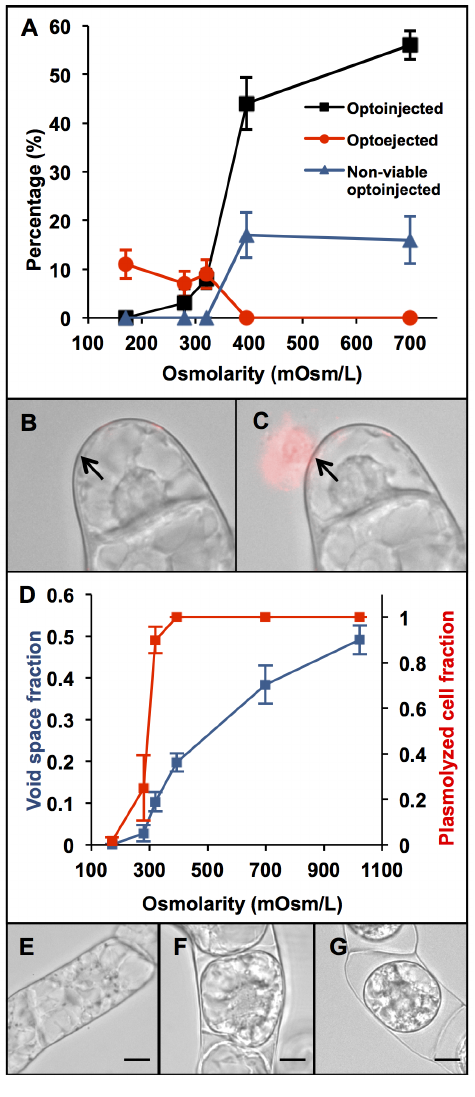
Figure 4. Optoinjection efficiency differs depending upon the osmolarity of the surrounding medium. From looking at A, as we increase the osmolarity, the efficiency of optoinjection (black squares) increases from zero up to 50% as the surrounding medium changes from hypertonic to hypotonic. Conversely, the optoejection efficiency (red circles) falls from around 10% to 0% above 320 6 2 mOsm/L. As the molarity of the solution increases, the likelihood of cell death (represented by blue triangles) is increased. At 320 6 2 mOsm/L the optoinjection and ejection efficiency are approximately equal. Each data point was performed in triplicate with 20 cells; error bars represent S.E.M. B and C show brightfield and fluorescence overlays of a cell prior to (B) and 2 minutes after (C) laser irradiation in standard culture medium in the presence of PI. Photoporation induces a flux of cytosol from the cell into the extracellular medium. The cytosol ejected from the cell becomes stained with PI and a bright fluorescence is seen exterior to the cell. Large changes in cell morphology occur and cell death is induced. D shows the osmotic effect on plasmolysis of BY-2 cells. Both the void space (blue) and fraction of plasmolyzed cells (red) increases with the osmolarity of the surrounding medium but the red line shows a much steeper incline around the point of incipient plasmolysis (50%). Error bars denote the S.E.M. for n=3 experiments with 20 cells counted in each. E-G show example cells in standard culure medium (171 6 2 mOsm/L), very weakly hypotonic (320 6 2 mOsm/L) and strongly hypotonic (699 6 4 mOsm/L) solutions respectively, with the resulting plasmolysis occurring slightly in F but seen very strongly